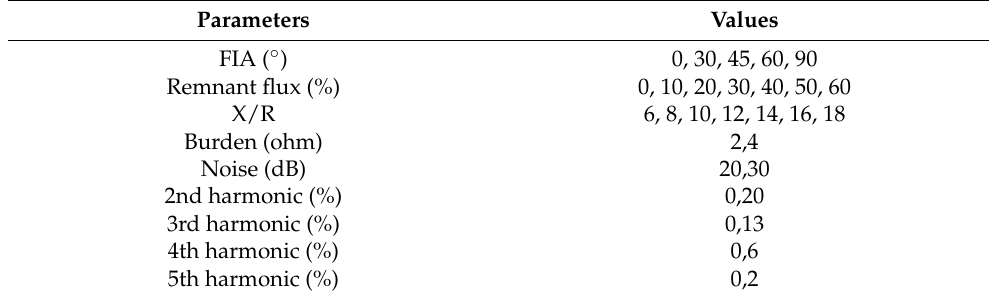
Table 1. CT saturation highly influential parameters for training datasets. Parameters